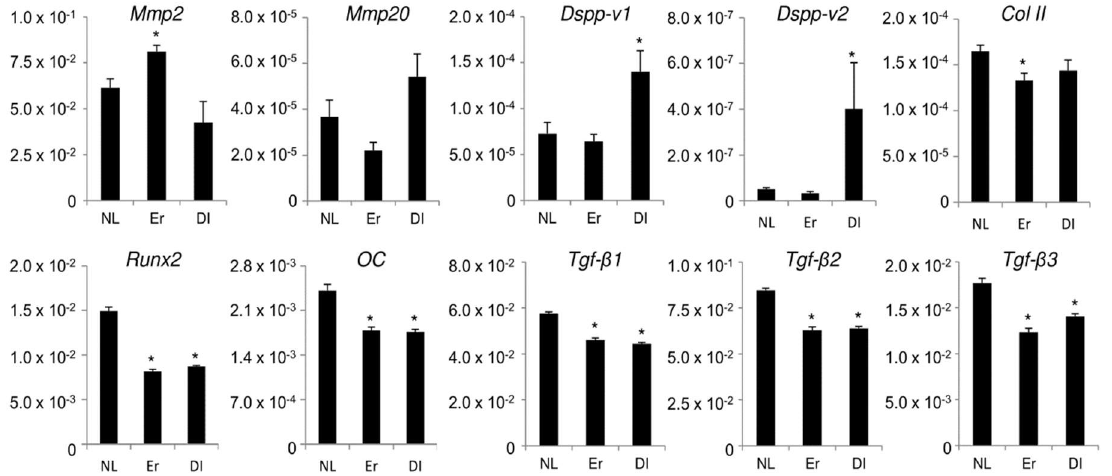
Figure 3. Effect of LI on gene expression in PPU-7. The mRNA expression assessed by qPCR analysis of MMP2 ( Mmp2 ), MMP20 ( Mmp20 ), DSPP-variant 1 ( Dspp-v1 ), and DSPP-variant 2 ( Dspp-v2 ) as odontoblastic differentiation markers; osteocalcin ( OC ) and runt-related transcription factor 2 ( Runx2 ) as osteoblastic differentiation markers; type II collagen ( Col II ) as a chondrogenic differentiation marker; and three TGF- β isoforms ( Tgf- β 1, Tgf- β 2 and Tgf- β 3 ). Each ratio was normalized using glyceraldehyde-3-phosphate dehydrogenase ( Gapdh ) as the reference gene, and the relative abundance of Dspp-v1 , Dspp-v2 , Mmp2 , Mmp20 , OC , Runx2 , Col II , Tgf- β 1 , Tgf- β 2 , and Tgf- β 3 in PPU-7 was generated based on a mathematical model for relative quantification in a qPCR system. Values are the means ± standard error of 6 culture wells. The asterisk (*) on the bar graph indicates a significant difference (* p < 0.05, Mann–Whitney U test) between samples with and without LI. NL: no LI; Er: Er:YAG-LI; DI: diode-LI.